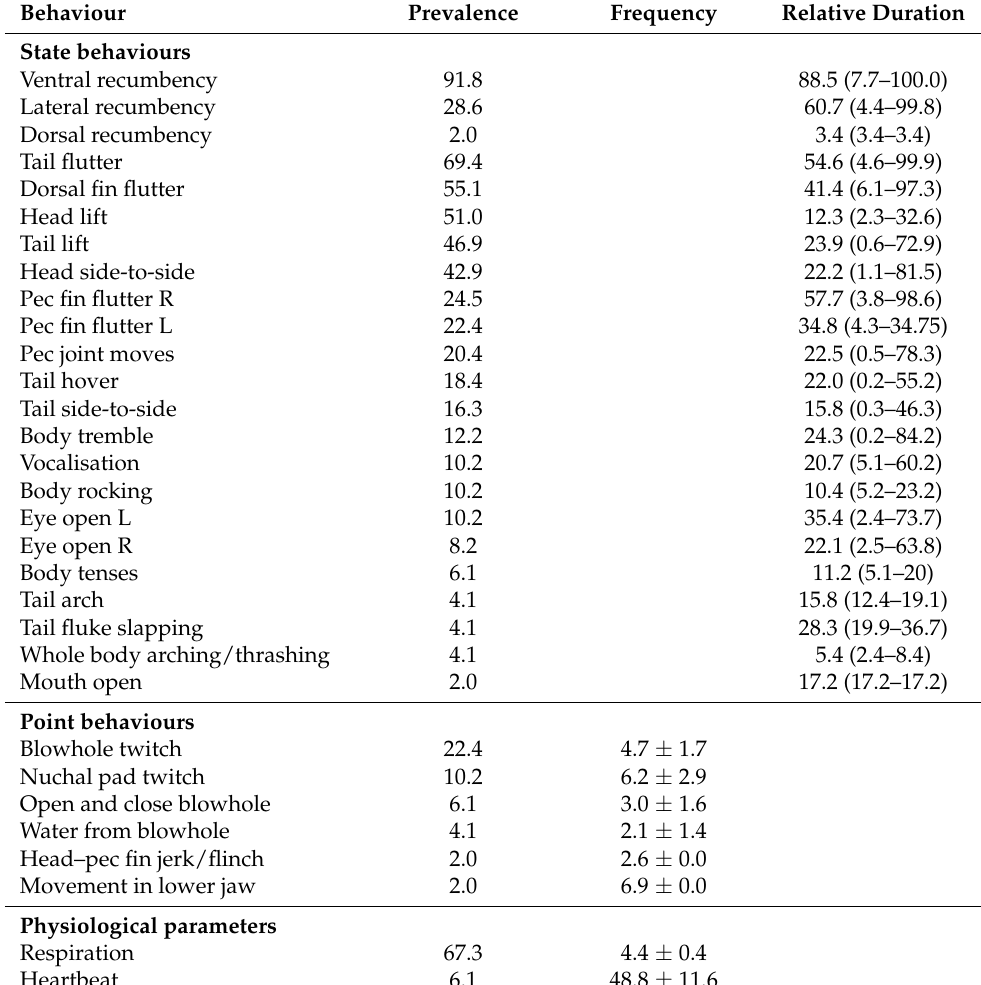
Table 3. Observed prevalence (% of individuals displaying or for which the indicator was feasible), mean frequency (rate/minute), or mean relative duration (% of observation period and range) for only long-finned pilot whales that displayed the behaviour, from a total of 49 individuals across 11 stranding events between August 2010 and March 2022. See Table S2 for descriptions of behaviours. Behaviour Prevalence